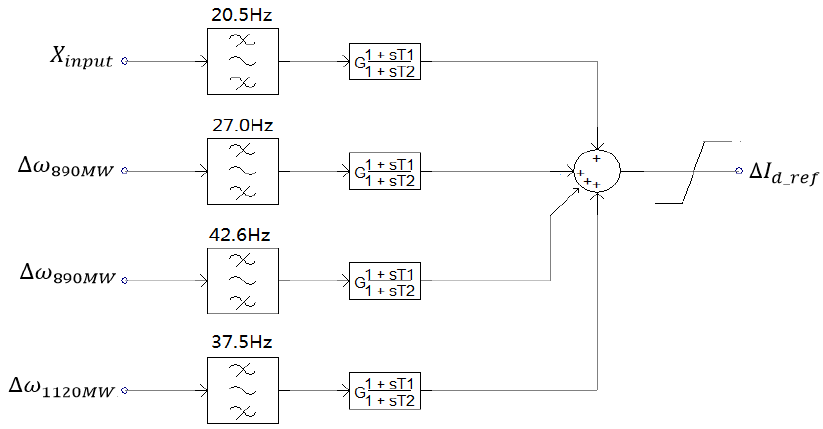
Figure 8. Whole structure of the SSDC.